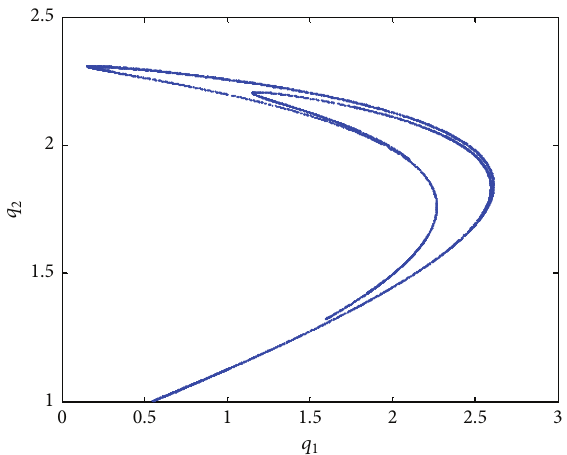
Figure 3: The strange attractor of the system at the parameter 𝛼 = 0.46